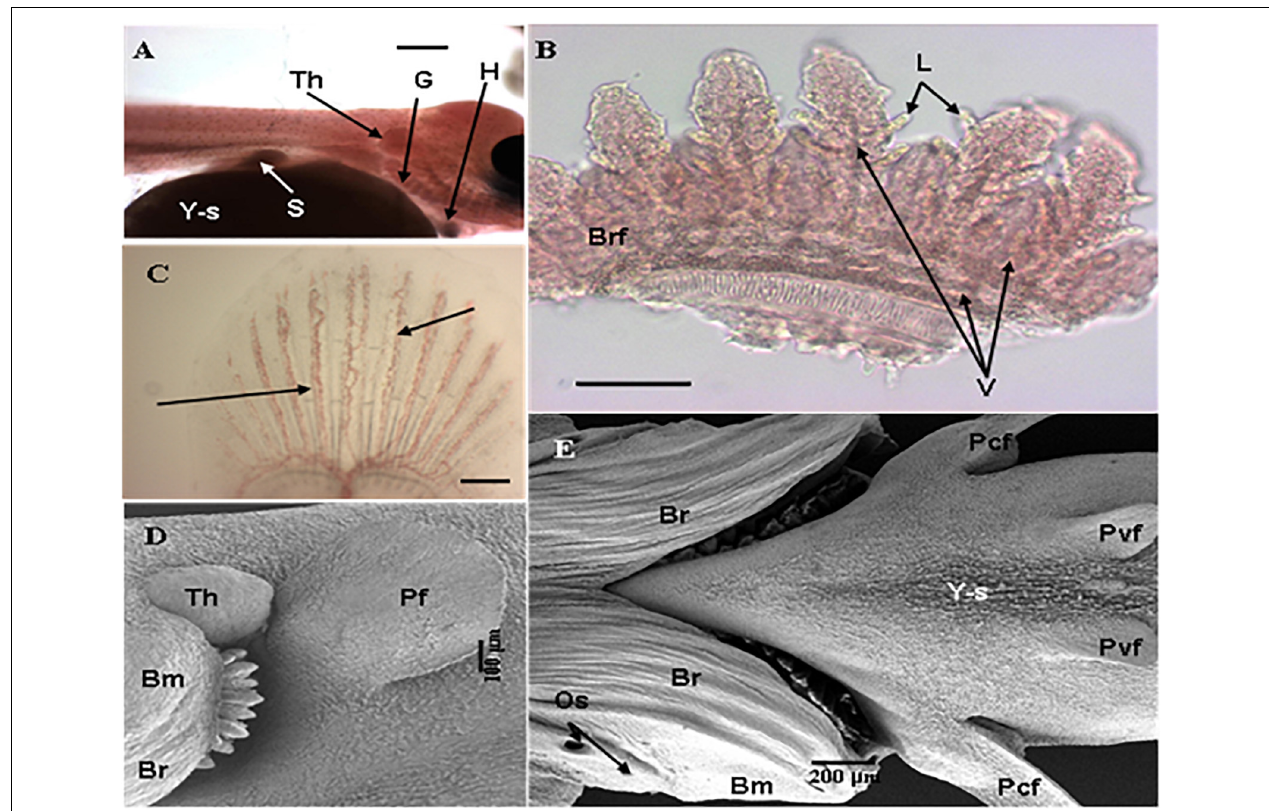
FIGURE 6 | Development of branchial system and vasculature in Nile tilapia. (A) Freshwater adapted larvae at 1 dph showing gills (G), budding thymus (Th), heart (H), yolk-sac (Y-s) and stomach (S) (Bar = 500 µ m) (LM), (B) Detail of branchial arch of freshwater adapted larvae at 1 dph showing pairs of hemibranchs or branchial filaments (Brf) with emergent lamellae (L) with clearly defined vasculature (V) (arrows) (Bar = 100 µ m) (LM), (C) Developing caudal fin of larvae adapted to brackish water at 3 dph showing vasculature (arrow) (Bar = 200 µ m) (LM), (D) Freshwater adapted larvae 3 dph showing pectoral fin (Pf), prominent thymus (Th) and branchiostegal membrane or operculum with visible branchiostegal rays (Br) partly covering gill arches and developing gills (Bar = 100 µ m) (SEM) and (E) Underside of brackish water adapted larvae at 7 dph showing gills completely covered by the fully-defined branchiostegal membrane (Bm) with branchiostegal rays (Br), opercular spiracles (Os) and pectoral (Pcf) and pelvic fins (Pvf) developing on shrunken yolk-sac (Y-s) (Bar = 200 µ m) (SEM) [from Fridman et al. (2011)].